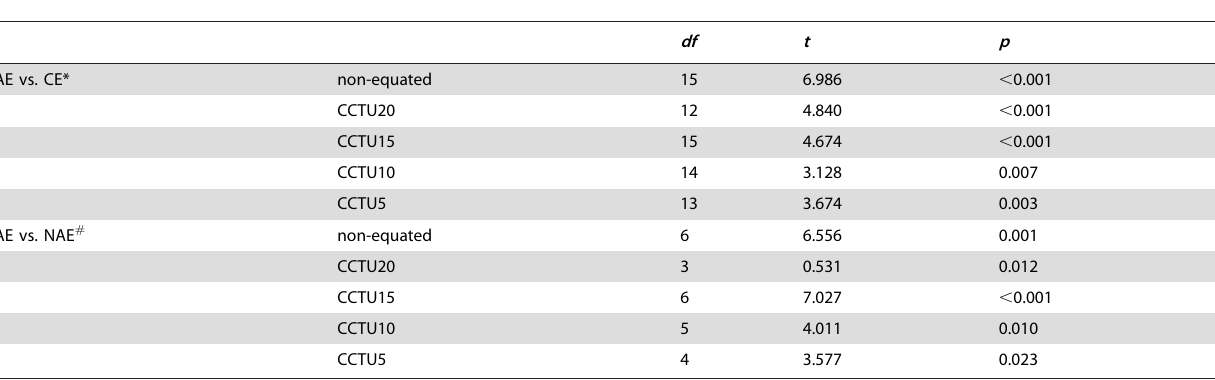
Table 2. Comparisons of contrast sensitivity for static second-order gratings.